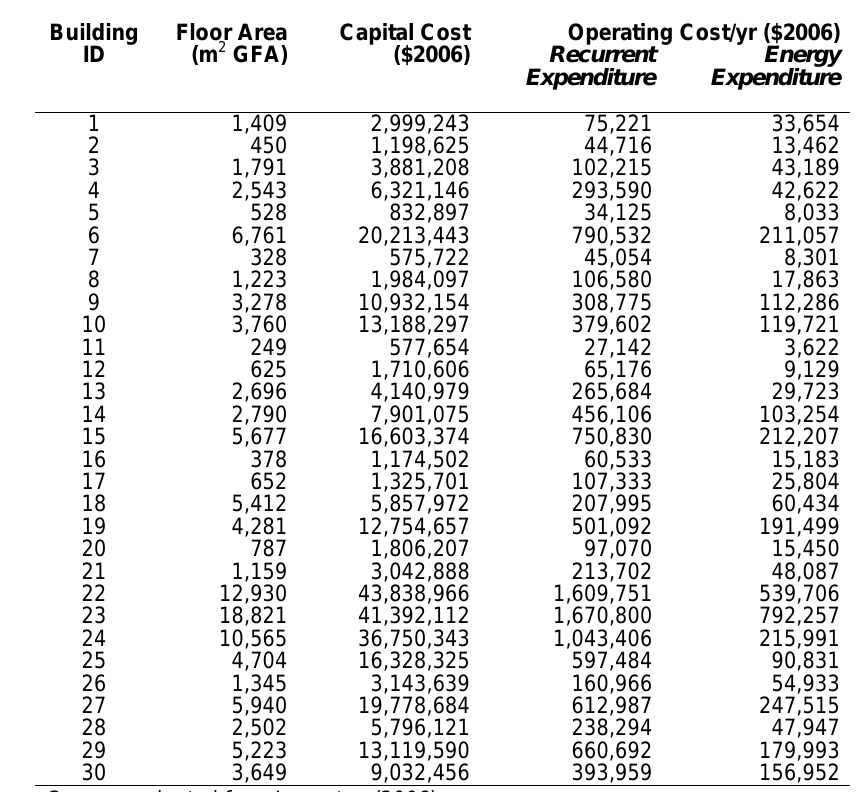
Table 3: Case study cost